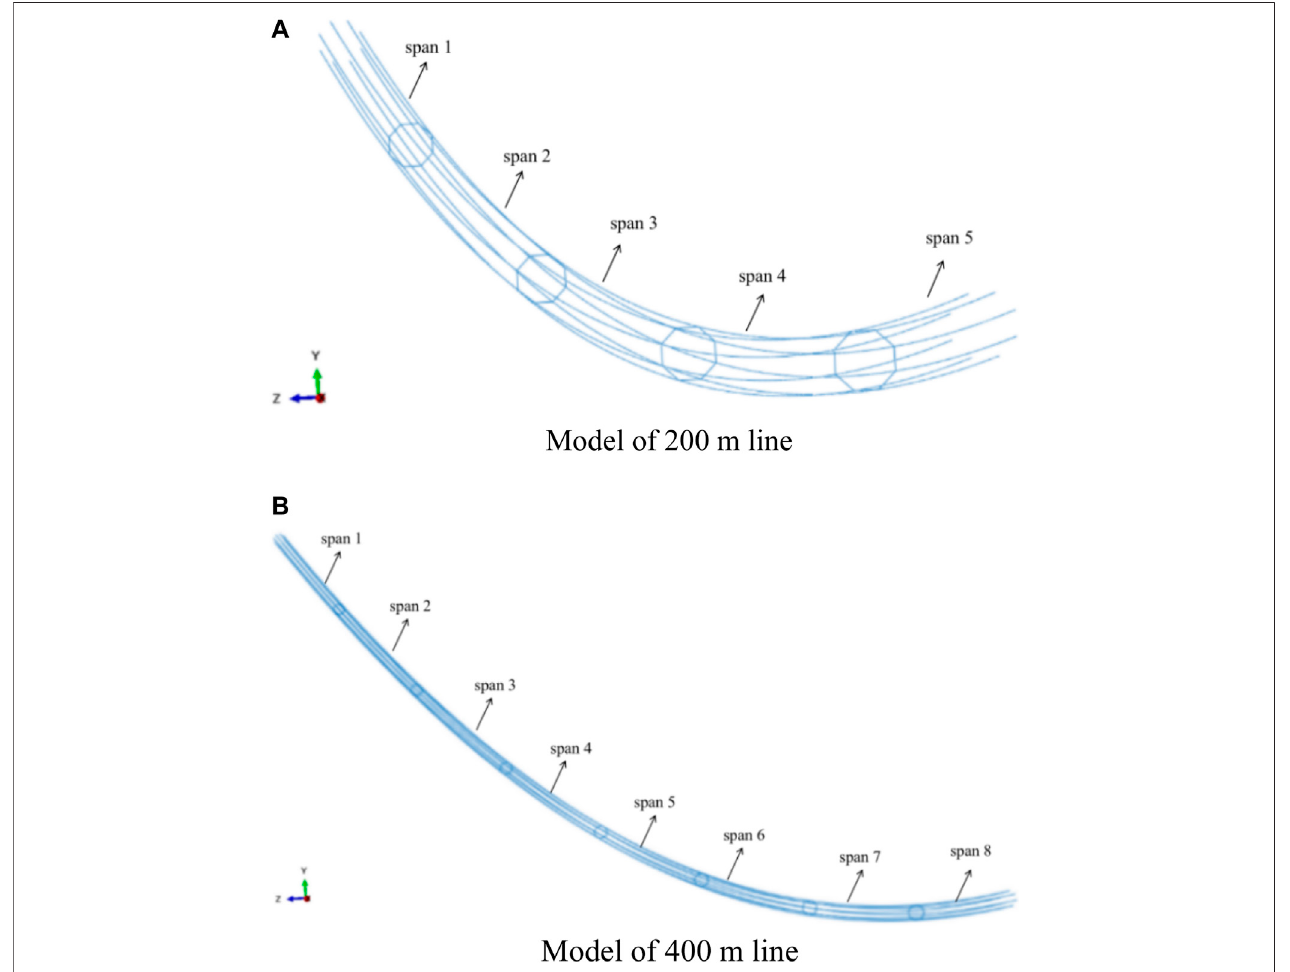
FIGURE 1 | Model of the eight-bundle conductor line. (A) Model of the 200-m line. (B) Model of the 400-m line.